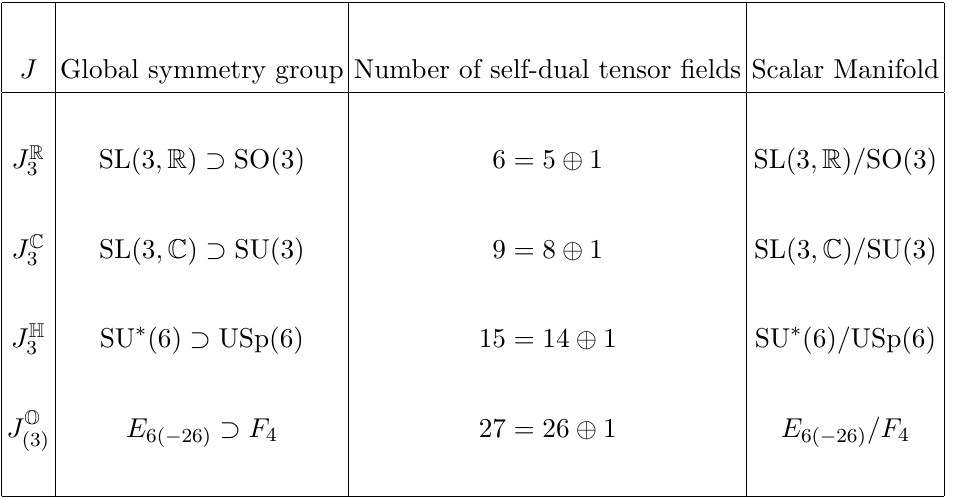
Table 5 . Unified tensor-Einstein supergravity theories in d = 6 that reduce to magical super- gravity theories in d = 5 defined by simple Euclidean Jordan algebras J A A = R , C , H , O . Second column lists their global symmetry groups and their maximal compact subgroups. Third column lists the number of tensor fields and their decomposition with respect to the maximal compact subgroup. The last column lists their scalar manifolds which are symmetric